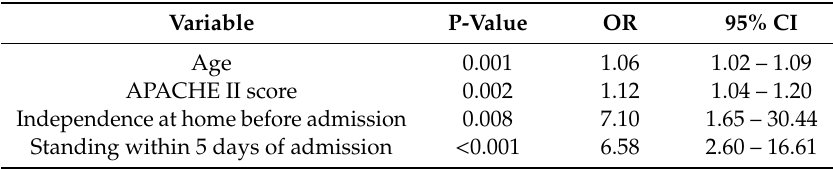
Table 3. Multivariate analysis of factors relating to home discharge or